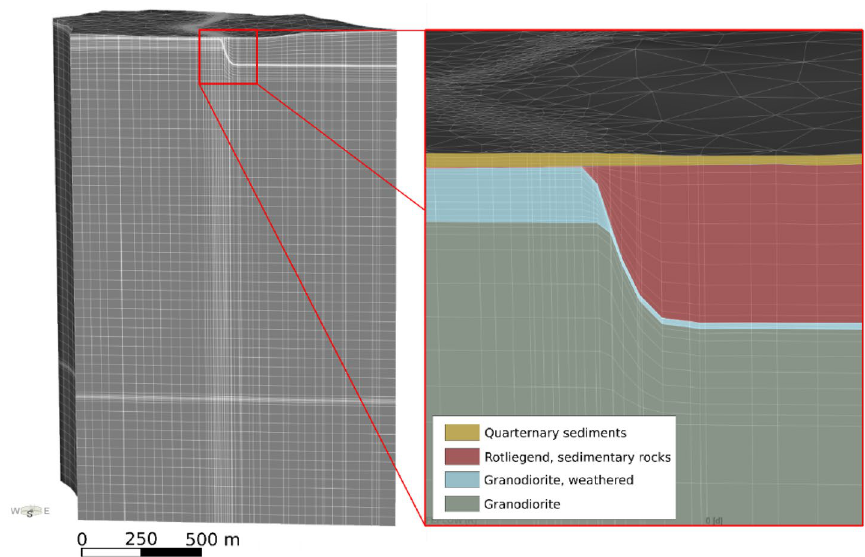
Fig. 7 FEFLOW 3D model with the distribution of the lithologies